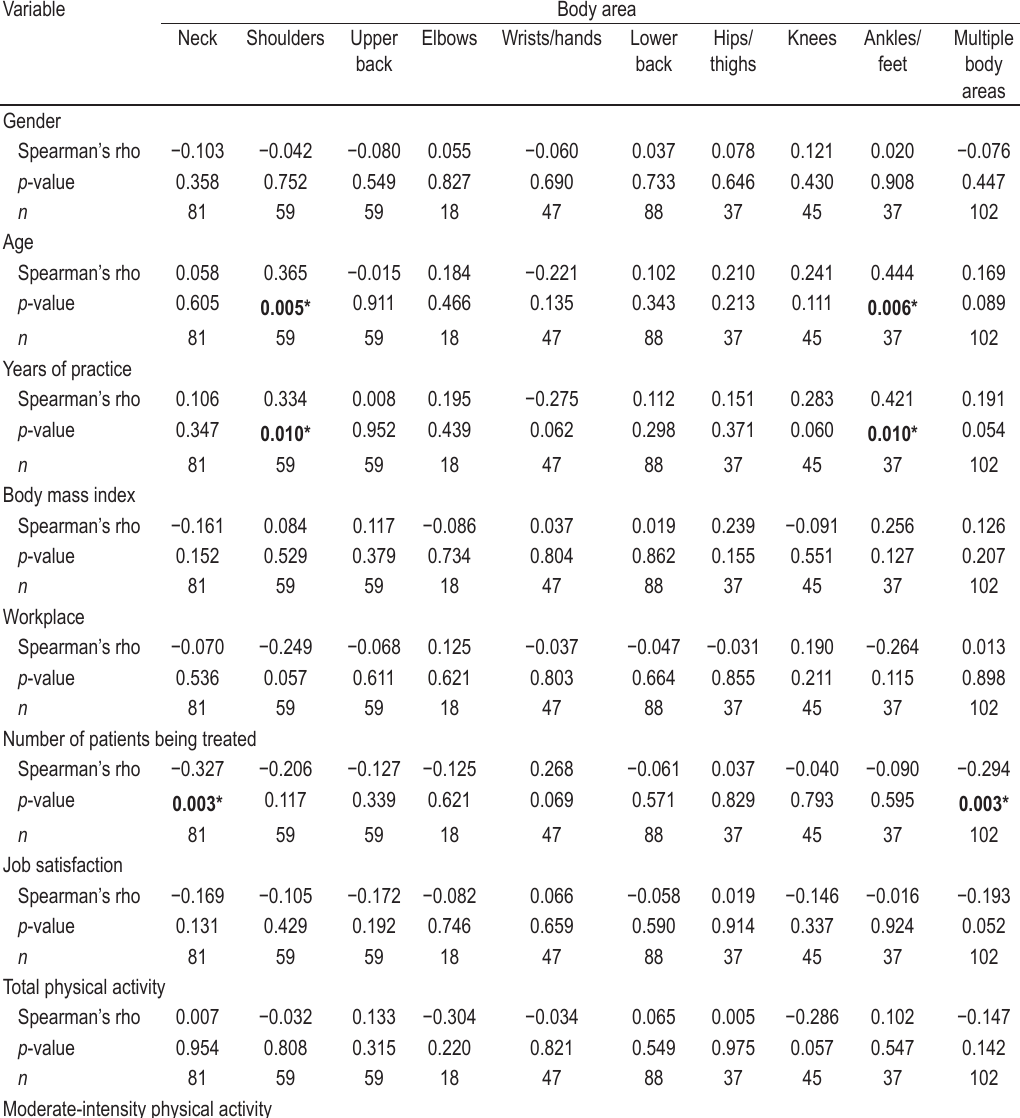
TABLE 3. Spearman correlation coefficient between variables and